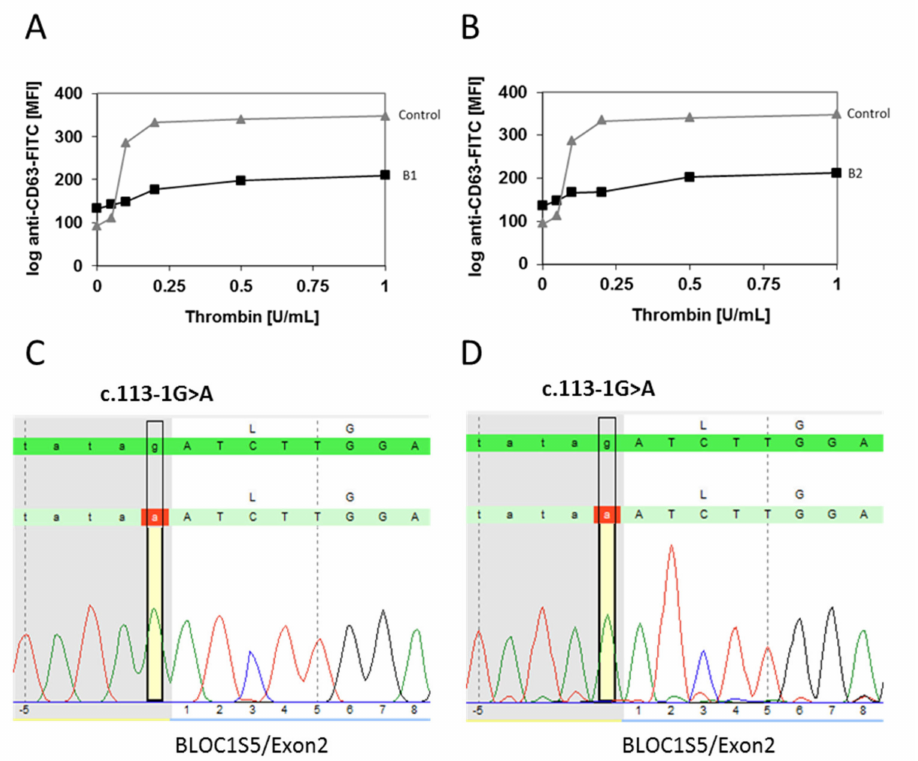
Figure 1. Upper panel: Platelet granule secretion after stimulation with thrombin (concentrations: 0, 0.05, 0.1, 0.2, 0.5, and 1.0 U/mL) for the two brothers using flow cytometry. Severely impaired δ